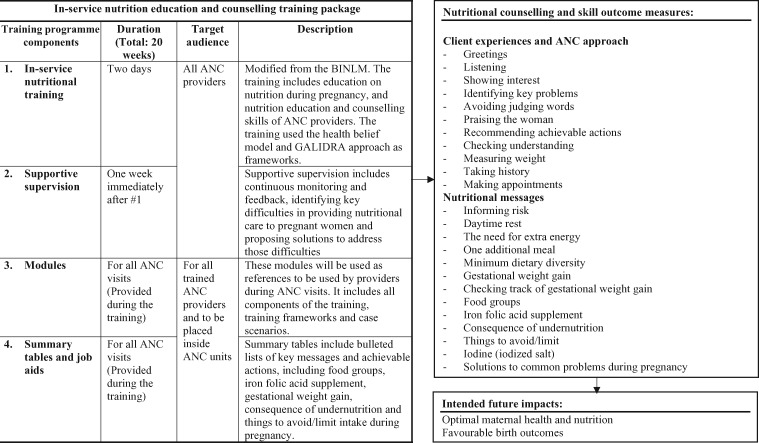
In-service nutrition education and counselling training package. ANC, antenatal care; ANCPs, antenatal care providers; BINLM, Blended and Integrated Nutrition Learning Module; GALIDRA, Greet, Ask, Listen, Identify, Discuss, Repeat, Appoint